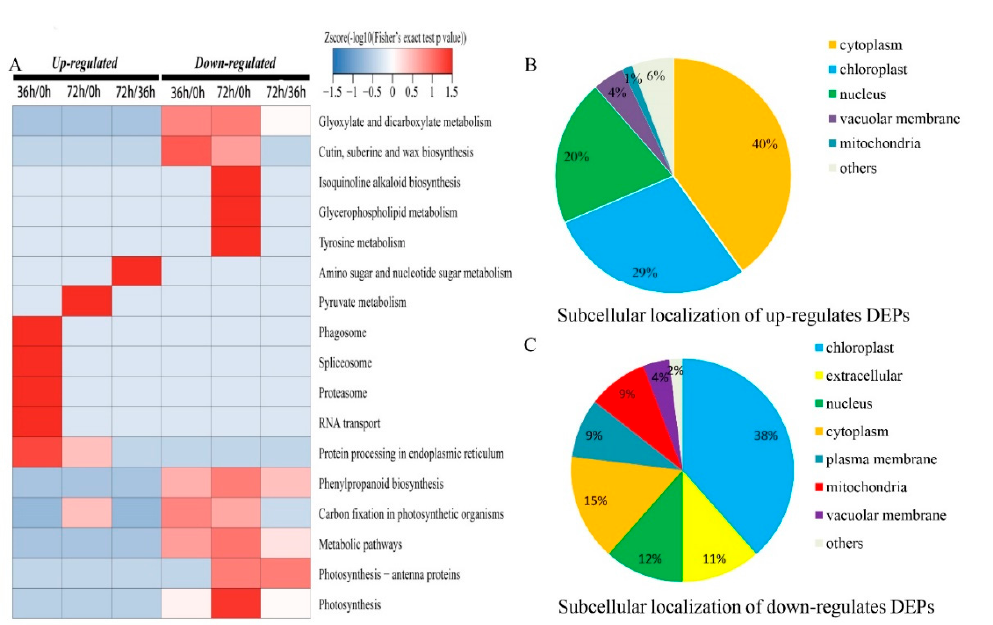
Figure 4. Kyoto Encyclopedia of Genes and Genomes (KEGG) enrichment analysis and subcellular localizations of DEPs. ( A ) the KEGG pathway; ( B ) the subcellular of up-regulated DEPs; ( C ) the subcellular of down-regulated DEPs.